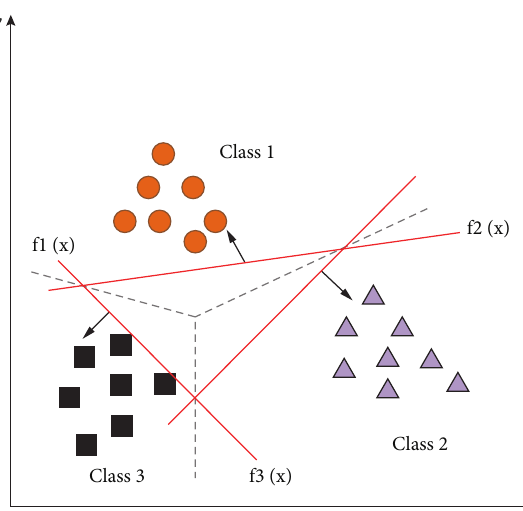
Figure 8: One vs many approach of the SVM technique.